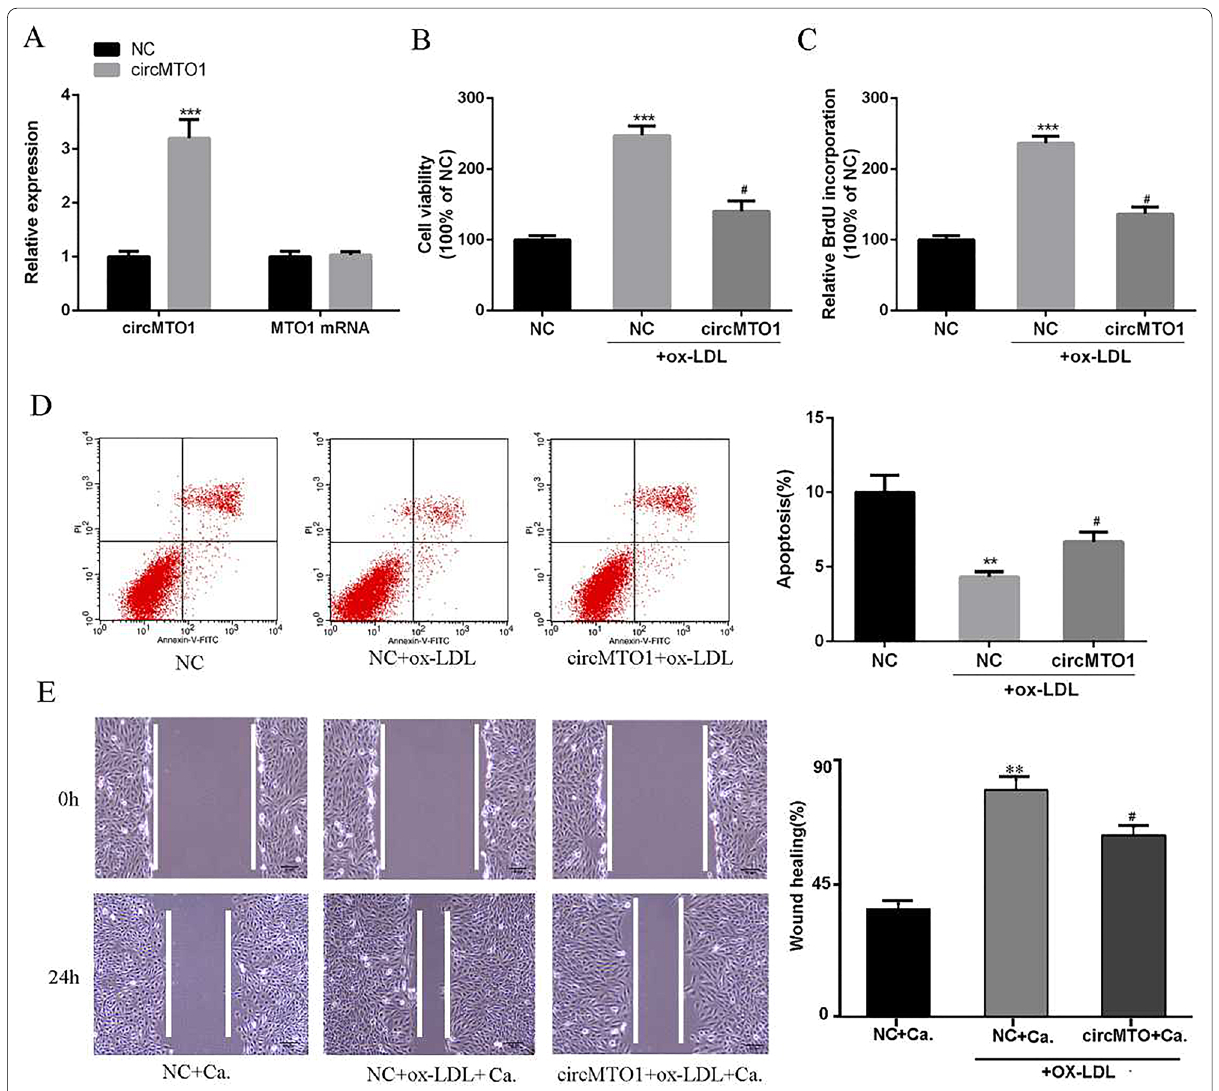
Fig. 2 CircMTO1 inhibited the proliferation and migration and induced the apoptosis of ox-LDL-stimulated VSMCs. A The mRNA expression levels of circMTO1 and MTO1 in VSMCs transfected with pcDNA 3.1-circMTO1. B , C The effect of circMTO1 overexpression on cell viability and proliferation determined by CCK8 and BrdU incorporation assays. D The effect of circMTO1 overexpression on apoptosis. E The effect of circMTO1 on cell ox-LDL capecitabine. Ca. indicates the migration. **P < 0.01, # P < 0.05 compared with NC + +